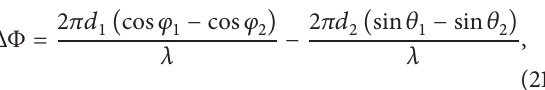
Figure 5: The image of joint two-dimensional processing.